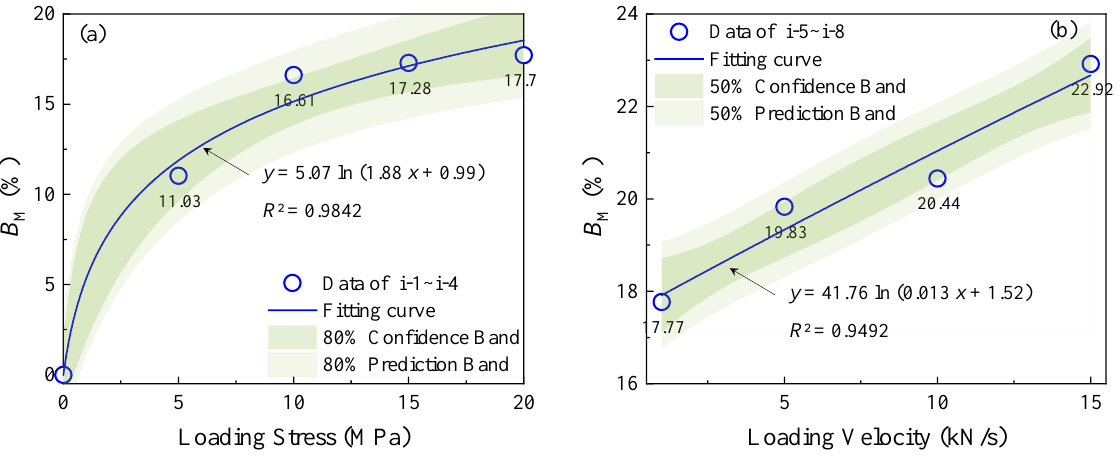
Figure 7. Trend of breakage ratio ( B M ) with main control factors: ( a ) is the trend of B M with loading stress for specimens i-1 to i-4; ( b ) is the trend of B M with loading velocity for specimens i-5 to i-8.